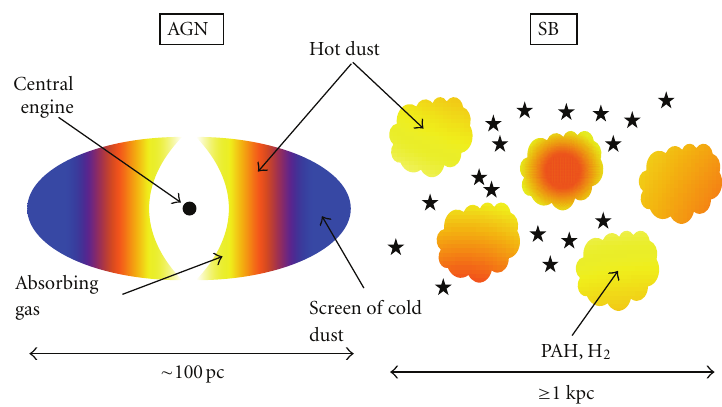
Figure 7: Schematic view of the possible spatial distribution of the absorbing/emitting medium in IRAS 20551-4250. The X-ray absorbing gas (in light yellow) is located within the dust sublimation radius and represents the inner edge of the axisymmetric (toroidal) absorber. The dusty regions emitting the thermal radiation are in orange (for both AGN torus and SB clouds). A compact, dense screen of cold dusty gas (in blue) forms the outer layer of the AGN absorber and is responsible for both continuum reddening and deep absorption troughs. PAH features and H 2 lines come from di ff use material spatially mixed with young stars (yellow/orange clouds). Due to the large spatial extent, only moderate internal obscuration is a ff ecting the SB